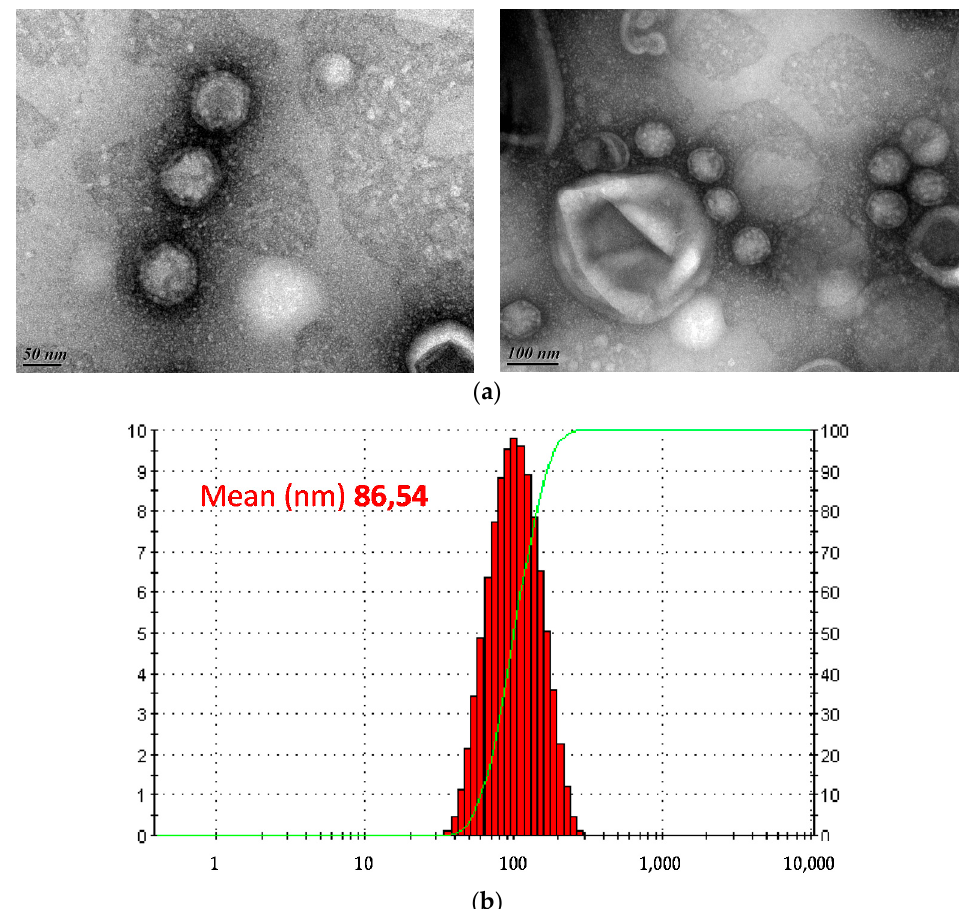
Figure 2. Morphology and size of BG1 particles. ( a ) Transmission electron micrographs of phage GC1. Scale bars are 50 nm (left) and 100 nm (right); ( b ) Average size (nm) of the particles in dynamic light scattering (DLS) analysis, using a Zetasizer Z/S system (Malvern, UK).